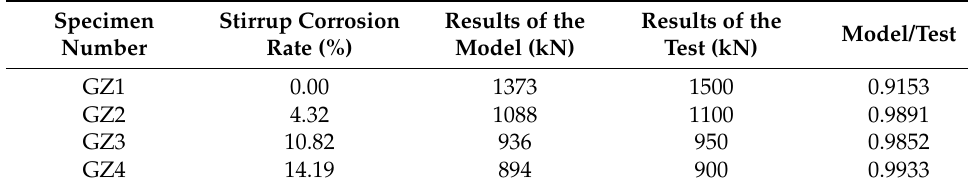
Table 5. Comparison between model results and experimental results.